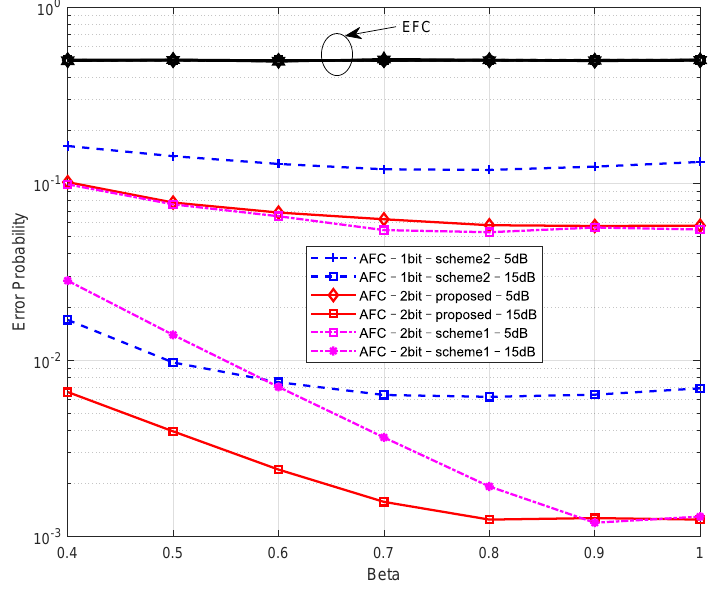
Figure 5. Error probabilities of the soft data fusion varying with β for SNR = 5, 15 dB and snr L = 5 dB.